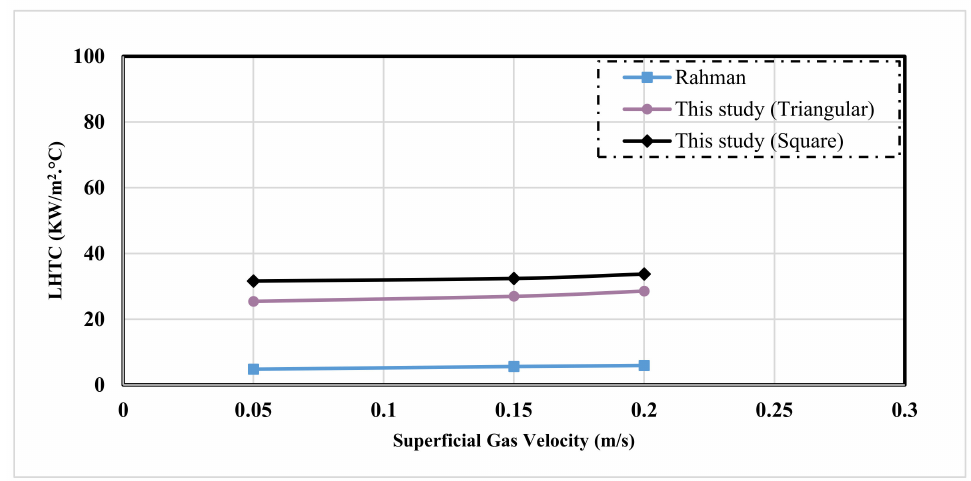
Figure 17. Comparison with existing data using different tube arrangemants in the center region at different superficial gas